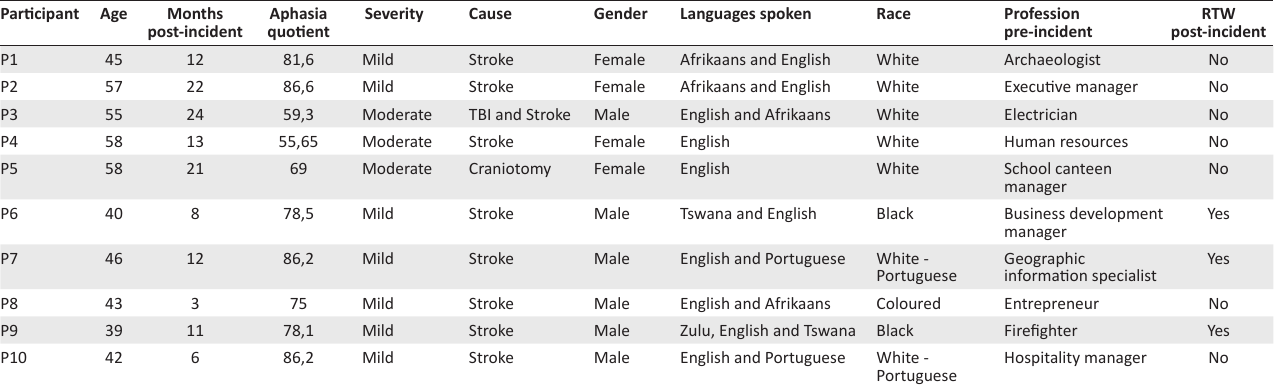
TABLE 1: Participant characteristics ( n =